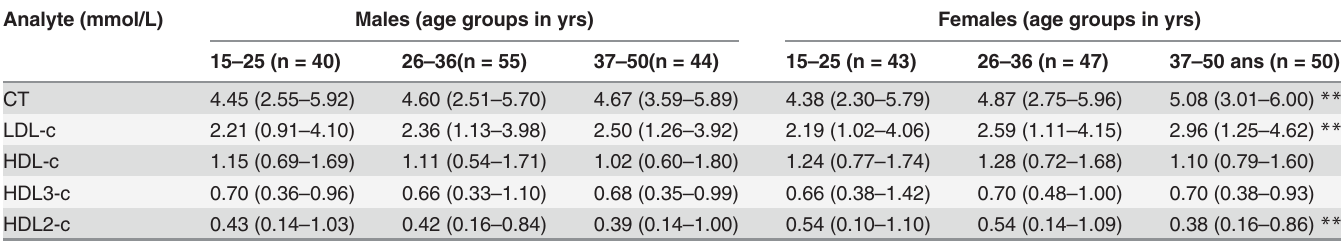
Table 5. Reference Ranges of cholesterol fractions according to age groups and sex [median (percentiles 2.5 et 97.5)]. Analyte